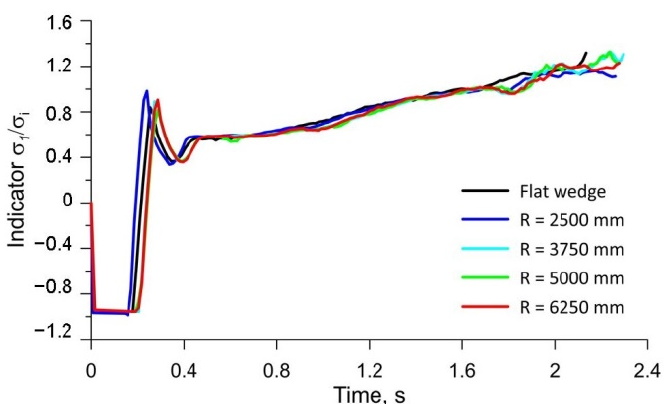
Figure 18. Variation in the stress ‐ state indicator σ 1 / σ i at point P2.